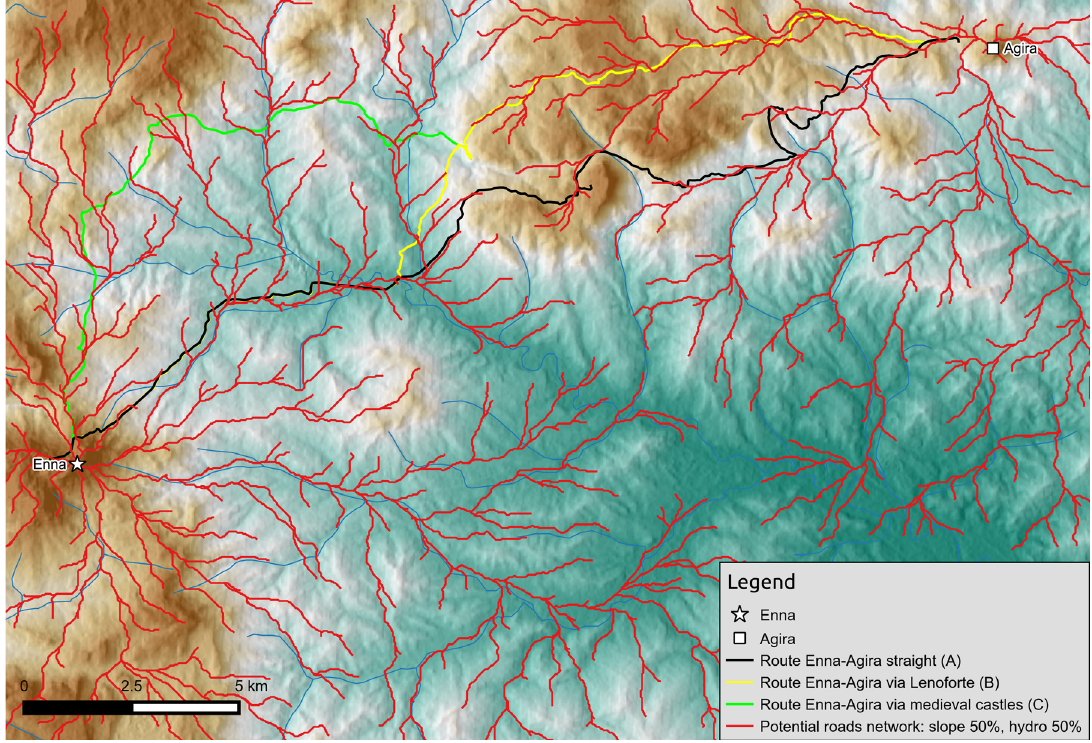
Fig. 6. The potential route network between Enna and Agira (red). They are both considered as the focus of the network. The potential and the historical network overlay each other almost